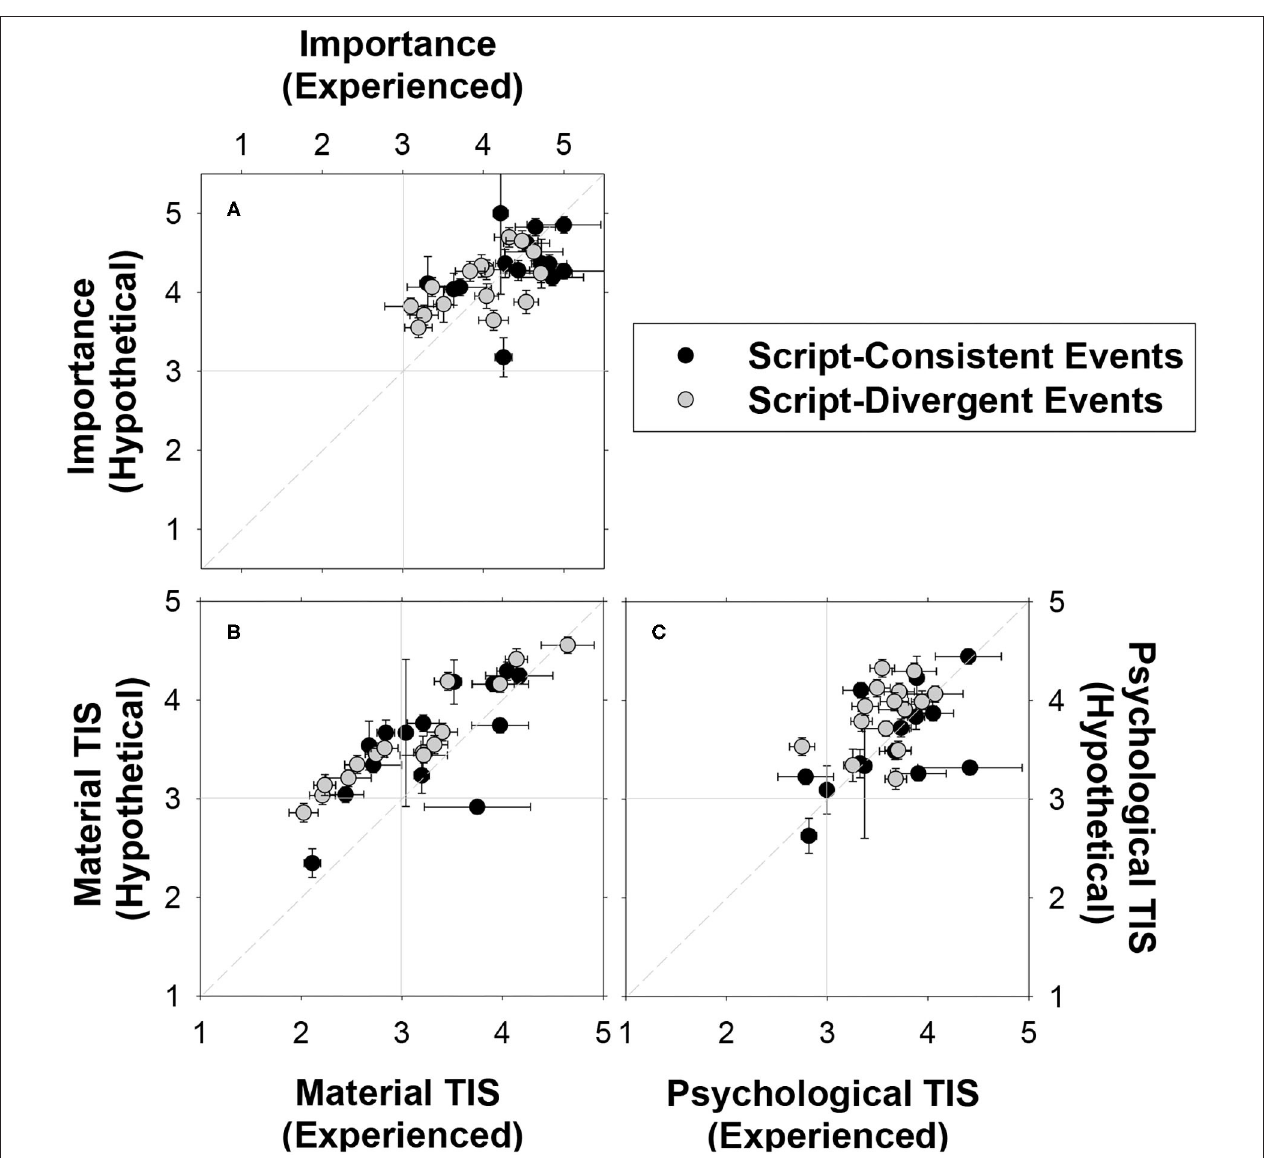
FIGURE 5 | Mean ratings of the importance (A) , material impact (B) and psychological impact (C) of script-consistent events and script-divergent events in the experienced condition (participants’ real life) and the hypothetical condition (average Canadian’s life). Error bars indicate ± 1 standard error of mean. The event, “begin grade school,” is omitted in the graphs because it only has estimates from the experienced condition (mean importance = 3.48, SE = 0.10; mean material TIS score = 2.66, SE = 0.07; mean psychological TIS score = 3.30, SE =